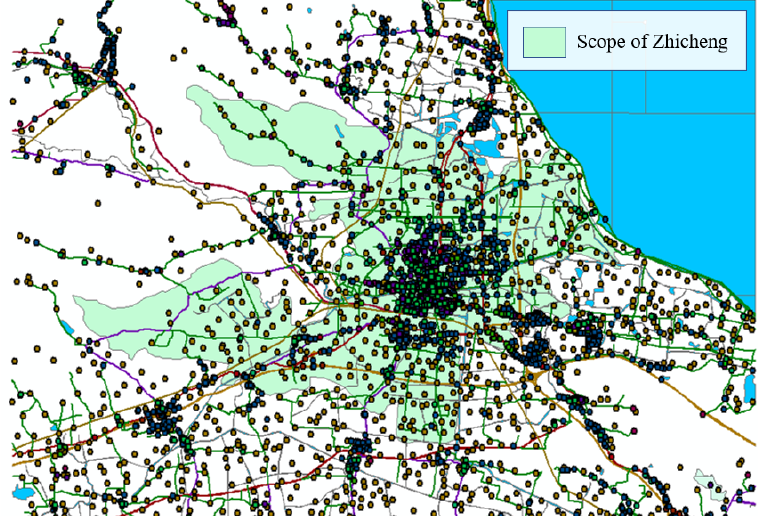
Figure 2. Preview of the map of Zhicheng.